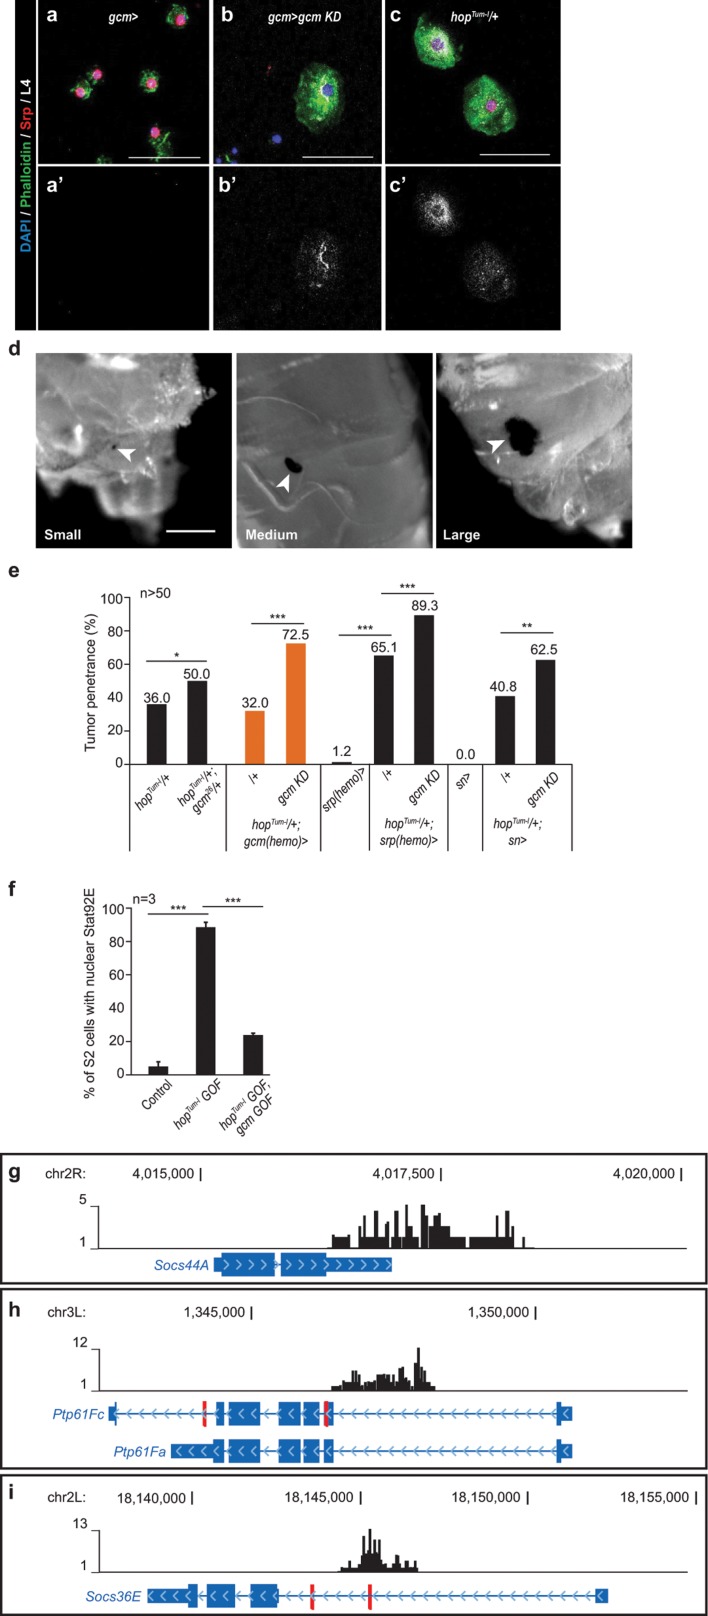
Gcm inhibits Jak/Stat-mediated melanotic tumor formation.(a–c) Immunolabelling of hemocytes from Wandering L3 of the mentioned genotypes (DAPI in blue, Phalloidin in green, Srp in red, lamellocyte marker L4 in white), (n > 3). Strong Phalloidin labelling is specific to lamellocytes (Avet-Rochex et al., 2010; Stofanko et al., 2010). In all fluorescent confocal images, maximum Z-projections are presented. (d) Melanotic tumors of different size (arrowheads). See Materials and methods for quantitative assessment. (e) Tumor penetrance in hopTum-l/+;gcm26/+ larvae (column 2), hopTum-l/+;gcm(hemo)Gal4/+ (column 3), hopTum-l/+;srp(hemo)Gal4/+ (column 6) and hopTum-l/+;snGal4/+ (column 9) or upon gcm KD (columns 4, 7 and10) as compared to controls (n > 50). (f) Percentage of S2 cells presenting nuclear Stat92E labelling after transfection with pPac-gal4 and pUAS-RFP (Control), or pPac-gal4, pUAS-RFP and pUAS- hopTum-l (hopTum-l GOF), or pPac-gal4, pUAS-RFP, pUAS- hopTum-l and pPac-gcm (hopTum-l GOF, gcm GOF). The quantification was done on at least 20 cells in triplicates. The labelling is displayed in Figure 2a–c. (g–i) Loci containing DamID peaks (black), Gcm binding sites (GBSs, in red), blue arrows within the loci indicate the direction of transcription, histograms above the locus show a region of 1 kb on each side of a DamID peak scoring a FDR < 0.001, genomic coordinates of the loci are indicated above the histograms: Socs44A (g), Ptp61Fa (cytoplasmic isoform) and Ptp61Fc (nuclear isoform) obtained upon alternative splicing at the 3’ carboxyl terminal of Ptp61F (h) and Socs36E (i).